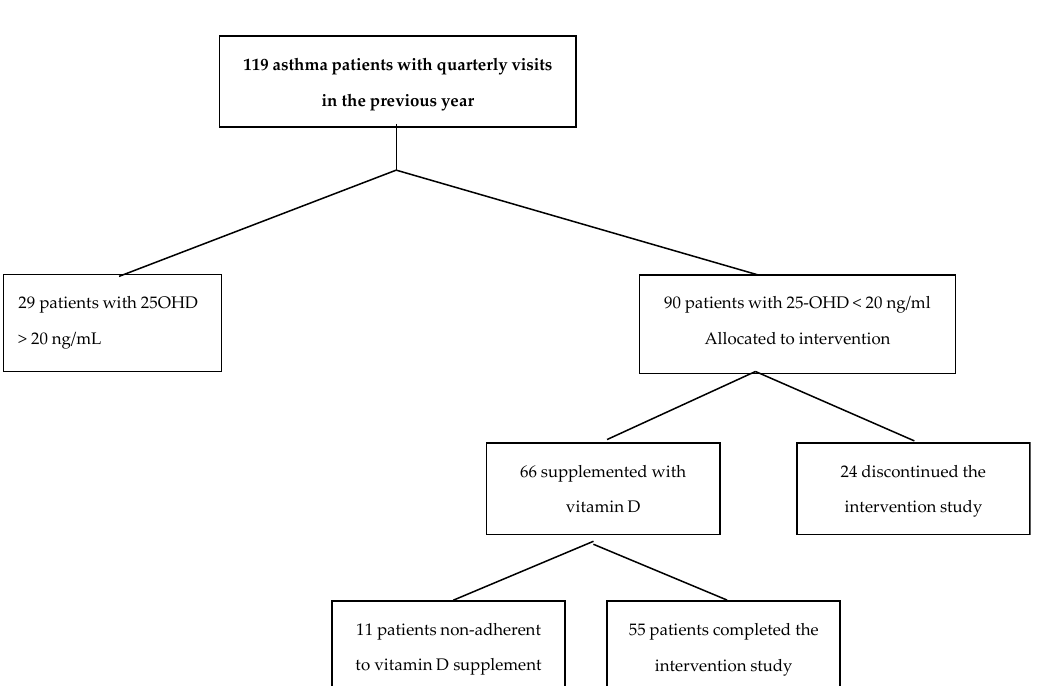
Figure 1. Consort flow diagram showing the design and conduct of the study.